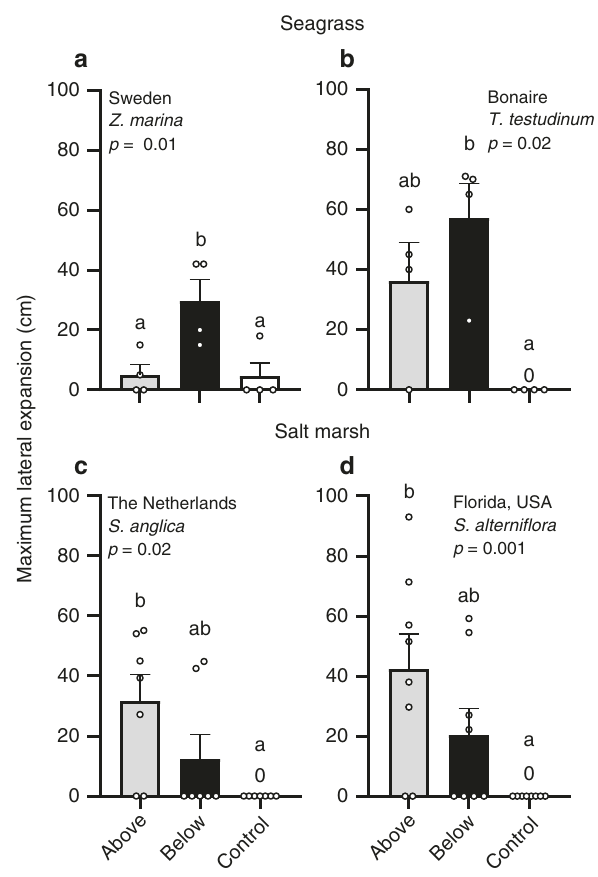
Fig. 4 Maximum lateral expansion of the transplants. a , b Seagrass expansion in Sweden ( n = 4) and Bonaire ( n = 4) in above- (gray) and belowground structures (black), and controls (white). c , d Cordgrass expansion in the Netherlands ( n = 7) and Florida ( n = 8). Data are presented as mean values + SEM. Exact p values are shown for treatment effects when p > 0.0001 (two sided). Signi fi cant contrasts are indicated by different letters ( p < 0.05, Benjamini – Hochberg corrections for multiple comparisons). Results of the statistical analyses are presented in Supplementary Table 3. Source data are provided as a Source Data fi